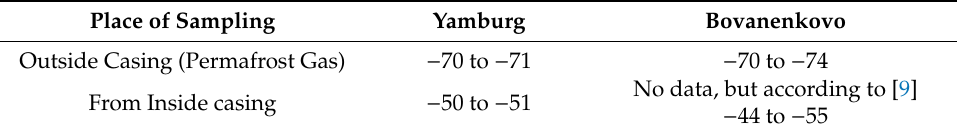
Table 2. Methane carbon isotopic ratio ( δ 13 C, %, ranges) in gas